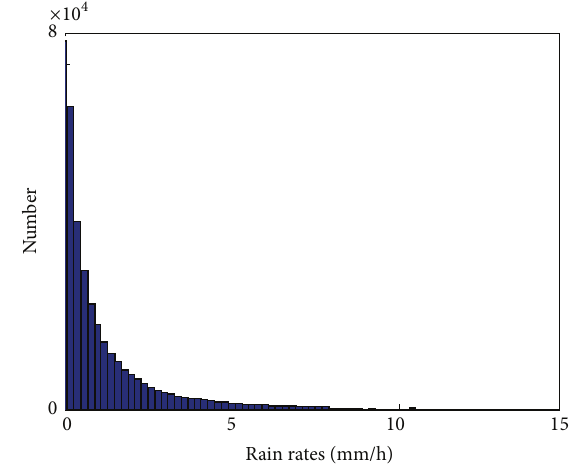
Figure 6: Distribution of rain rates in the TMI validation dataset for the time period of August 2012–April